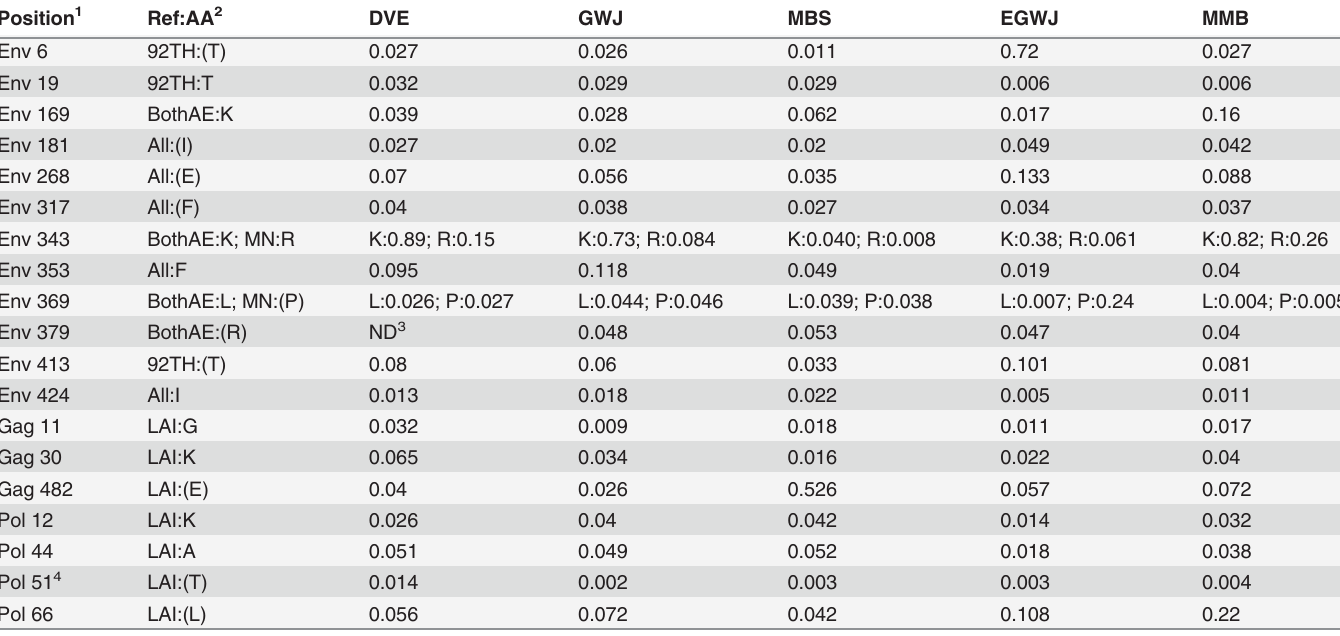
Table 1. Signature sites in vaccine proteins: 2-sided unadjusted p-values calculated by fi ve methods.